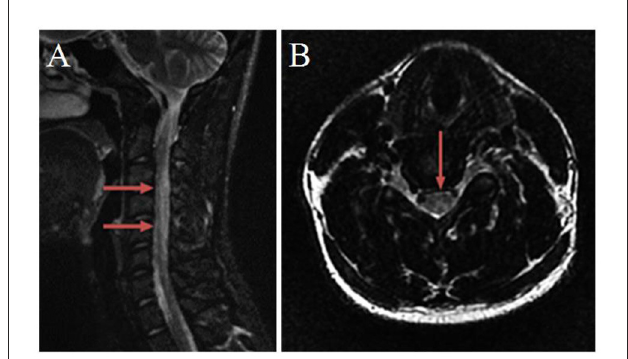
FIGURE1 Magnetic resonance imaging of the cervical spinal cord. (A) T2-weighted sagittal image, from C2 to C7 spinal cord hyperintensity. (B) T2-weighted axial image, an “inverted V-sign” was